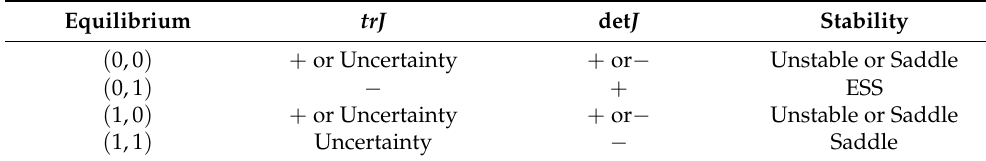
Table 5. Stability analysis of each equilibrium point.